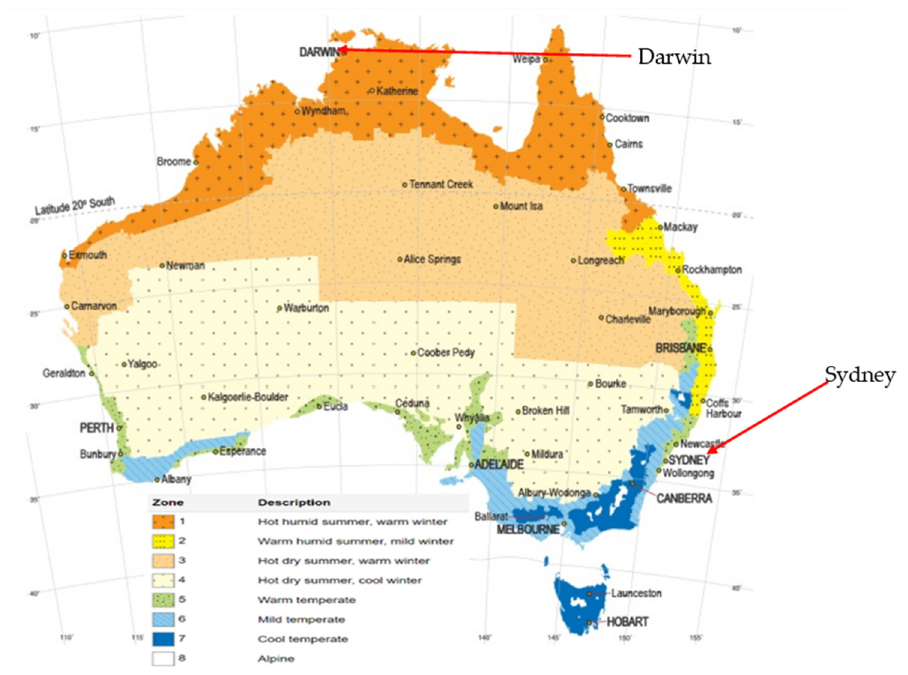
Figure 7. Map of Australia showing the climate types for building regulation energy efficiency simulation purposes Adapted http://www.nathers.gov.au. (accessed on 10 July 2018).